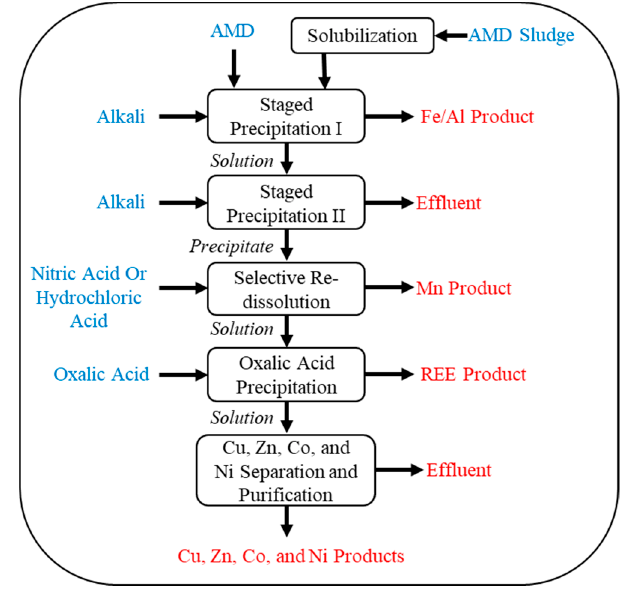
Figure 10. A flowsheet for multiple metals recovery from acid mine drainage (AMD) and acid mine drainage sludge.